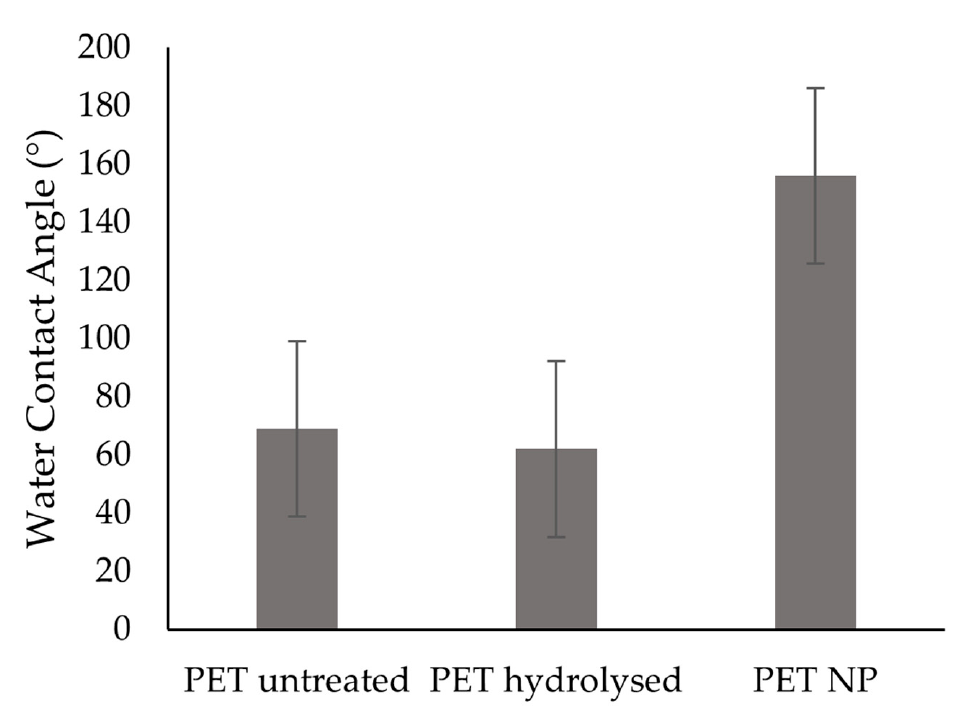
Figure 2. WCA for untreated and treated PET surfaces.